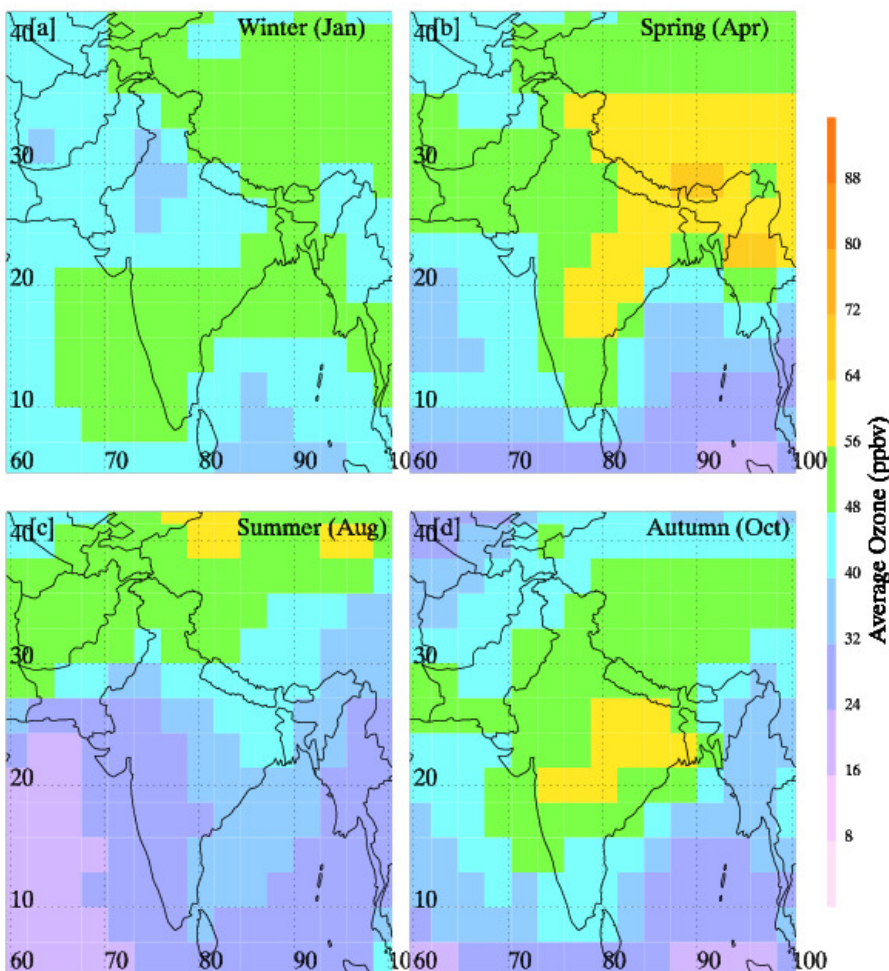
Figure 18: Spatial distribution of MOZART simulated surface ozone during January, April, 1358 Fig. 18. Spatial distribution of MOZART-simulated surface ozone during January, April, August and October of the year